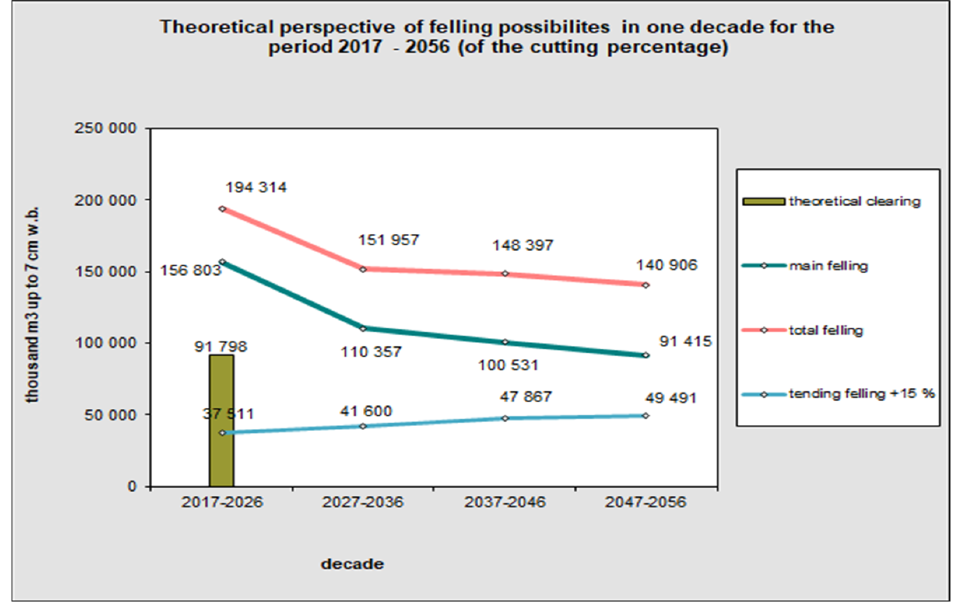
Figure 2. Theoretical perspective of felling opportunities in one decade for the period of 2014–2054.